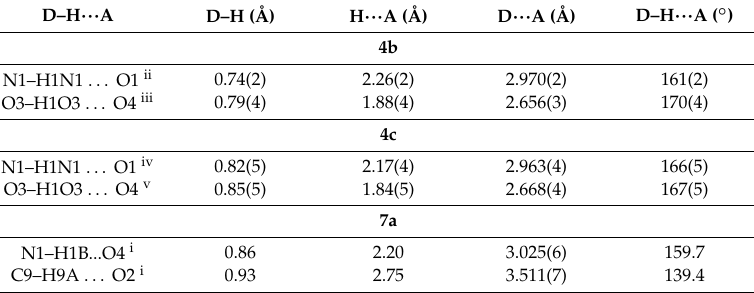
Table 3. Hydrogen bonds [Å and ◦ ] of the studied compounds.